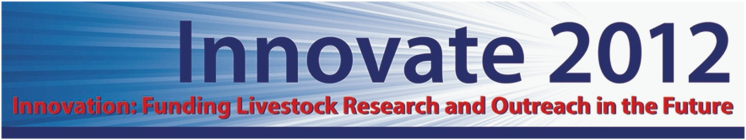
In 2012, the American Society of Animal Science launched the Innovate series of conferences with “Innovation: Funding Livestock Research and Outreach in the Future.”